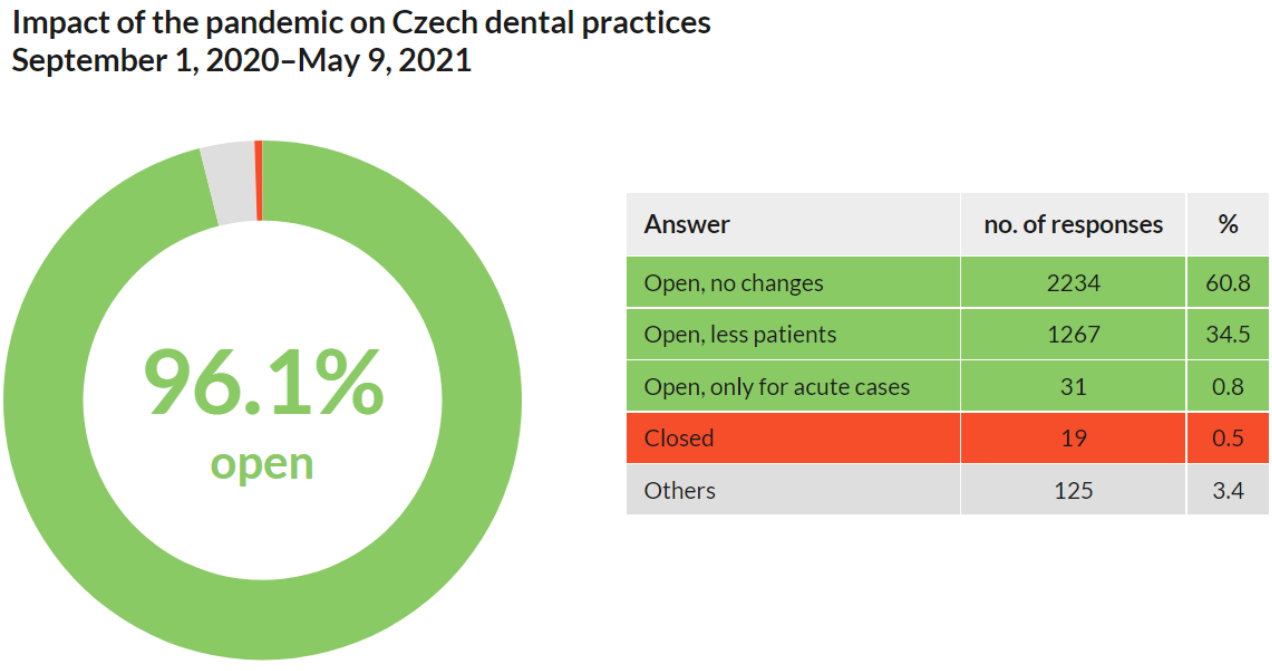
Figure 3. Impact of the pandemic on Czech dental practices from 1 September 2020 to 9 May 2021. More than 96% of them remained open.